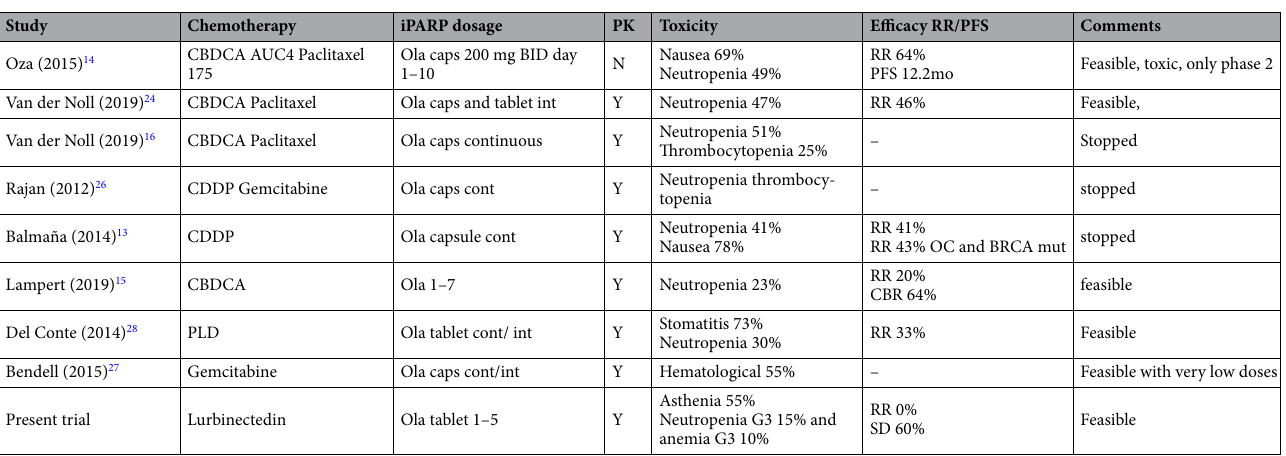
Table 3. Summary of main characteristics of combined phase I–II trials of olaparib and chemotherapy. AUC area under the curve, CBDCA carboplatin, CBR clinical benefit rate, CDDP cisplatin, Cont continuously, G3 grade 3, int intermittently, iPARP poly (ADP-Ribose) polymerase inhibitor, OC ovarian cancer, Ola olaparib, PFS progression-free survival, PLD pegilated liposomal doxorubicin, PK pharmacokinetics, RR response rate, SD stable